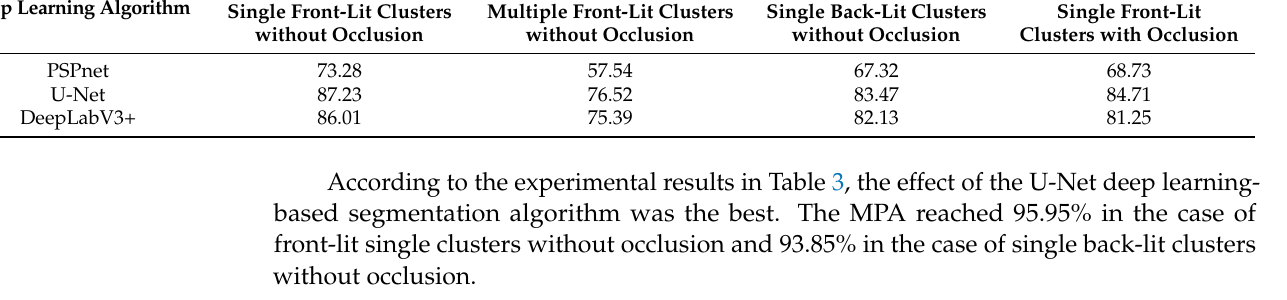
Table 2. The IOU comparison of deep learning segmentation methods. Table 1. Comparison of IOU for traditional image segmentation methods.